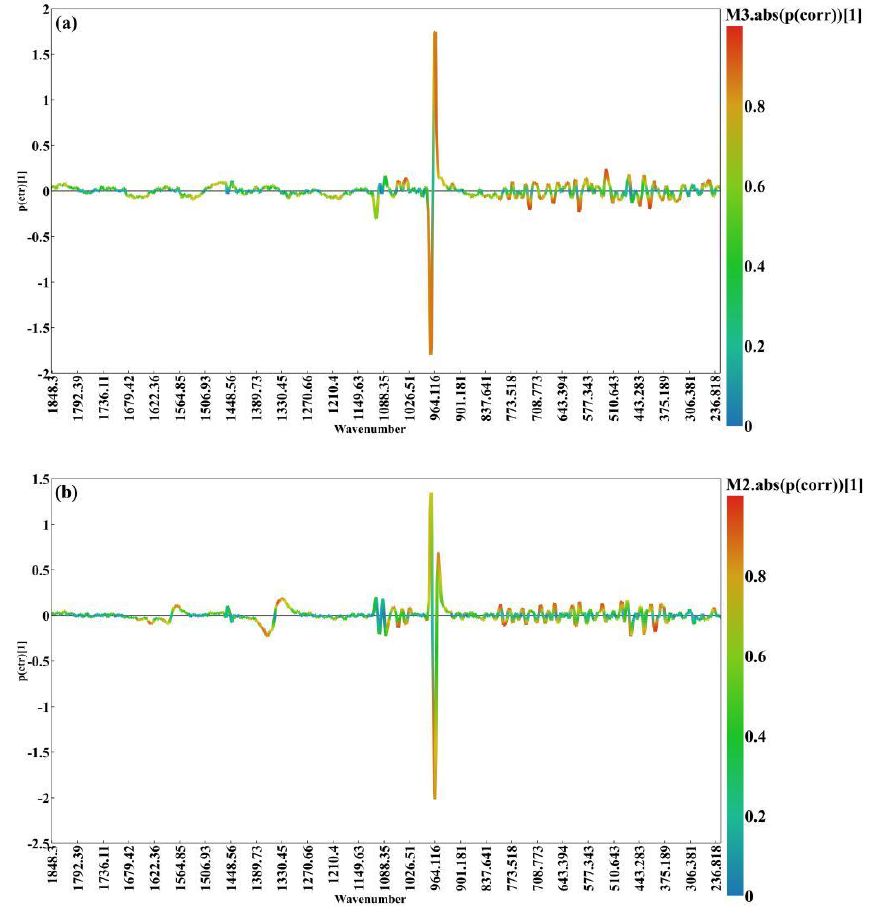
Figure 6. S-line plots between sample A and B ( a ), and between sample B and F ( b ).